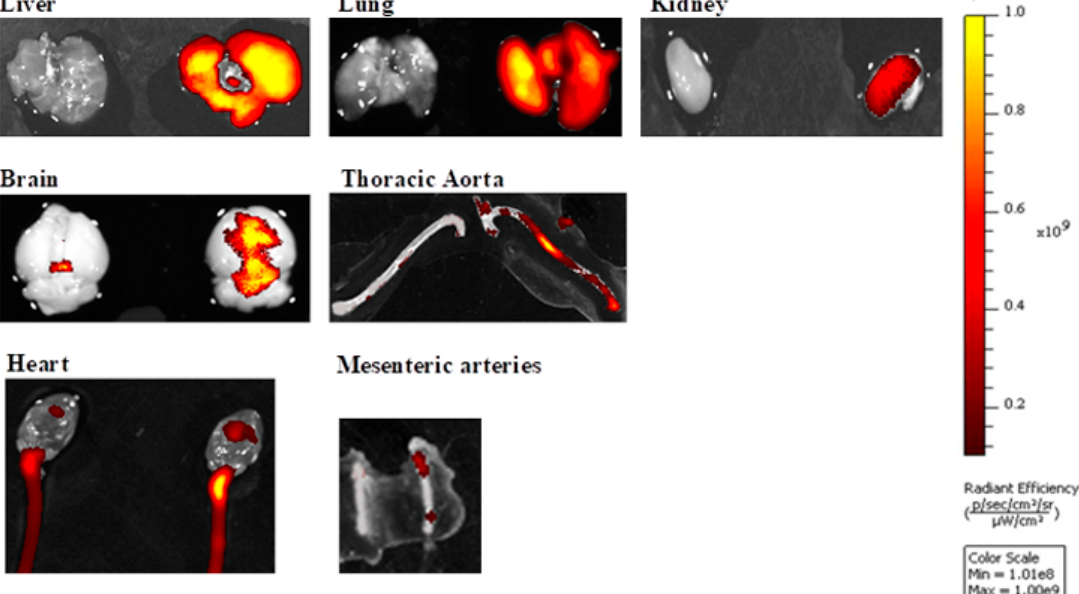
Figure 2. Representative images of organs / tissues (liver, lung, kidney, brain, heart, thoracic aorta, mesenteric resistance arteries) from the untransplanted HH group (on the left side of images in gray) and transplanted HH group (on the right side of images in red-yellow) analyzed with IVIS spectrum equipment for the presence of PKH26-labeled MVs or MVEs obtained by manual alignment of the spectrum. The color scale bar shows the range of strongest to weakest signal (1.01 × 10 8 –1.00 × 10 9 ). The intensity is strongest for the yellow colored points. The darker the spot, the weaker the signal. The number of animals per experimental working group was equal to